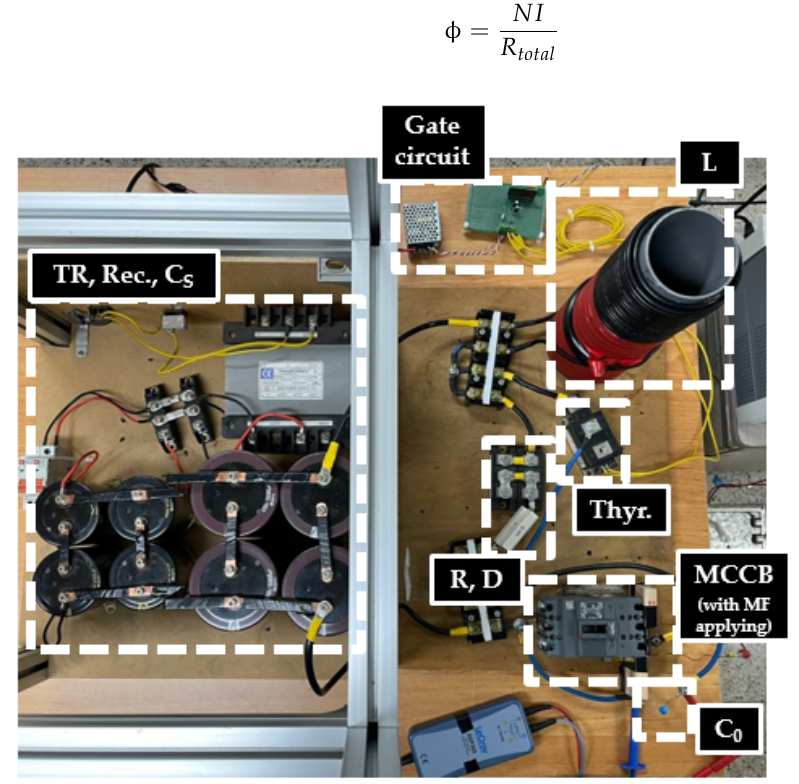
Figure 14. Test setup for disturbing magnetic field experiment.